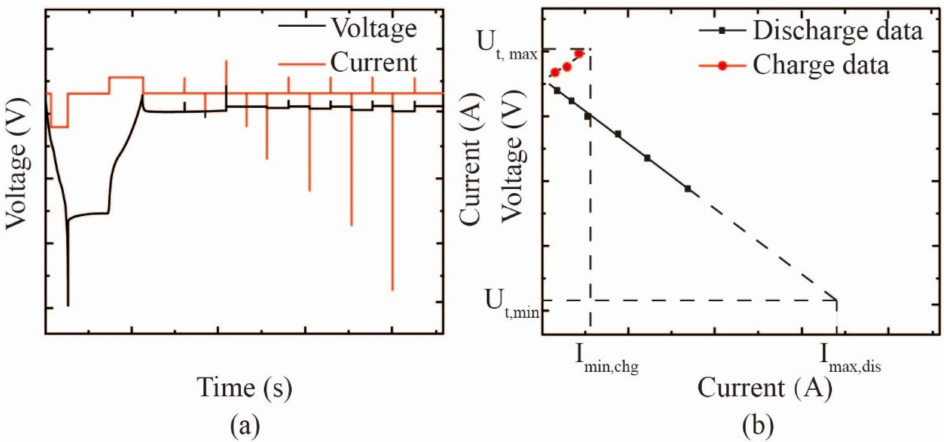
Figure 19. Hybrid pulse test: ( a ) current and voltage profiles; ( b ) peak charge and discharge current